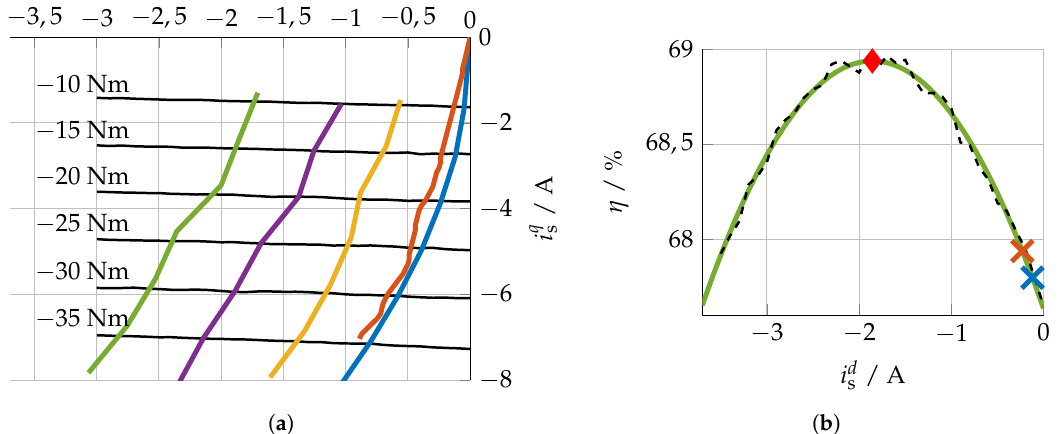
Figure 9. Comparison of the three presented methods. ( a ) Measured torque contour lines ( ) and resulting trajectories for the two MTPC methods with linear approximated ( ) and nonlinear ( ) flux linkages and the measured trajectories with the maximum efficiency for different shaft speeds of 100 rpm ( ), 200 rpm ( ), and 300 rpm ( ) in the ( d , q )-plane. ( b ) Efficiency ( ) for a shaft speed of 300 rpm and a constant torque of − 15 Nm and the two points of MTPC for linear approximated ( ) and nonlinear ( ) flux linkages and the point of maximum efficiency ( ).